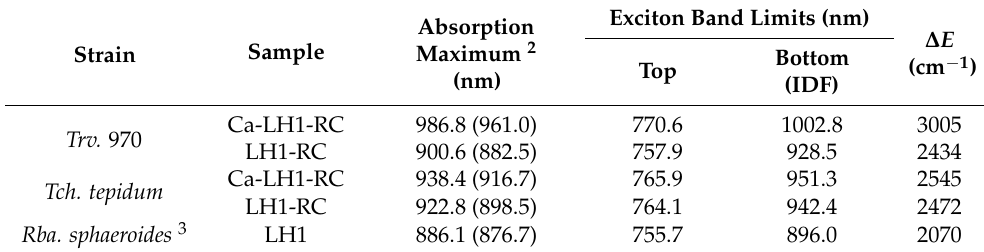
Table 1. Exciton band parameters for the core complexes studied at 4.5 K 1 .